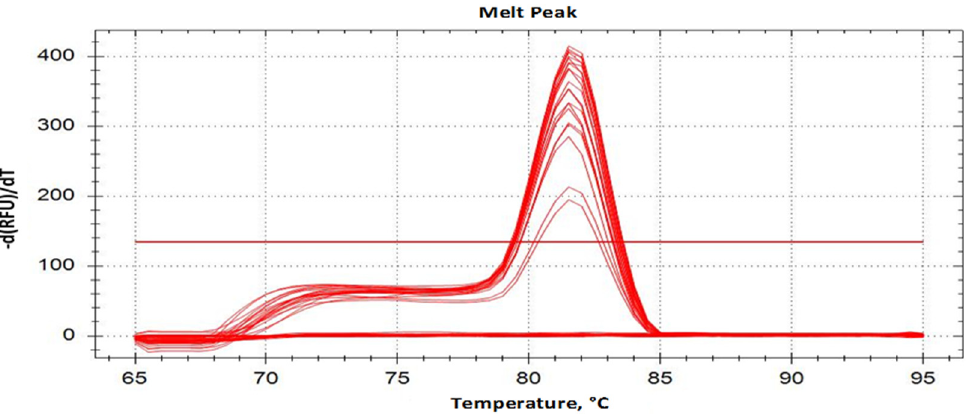
Figure 1. Melting curve profiles of P. dakotaensis . Amplicons with a single peak at a melting temperature of 81.5 °C were observed for populations of P. dakotaensis . Table 2. Taxon, geographic origin, current crop, and polymerase chain reaction (PCR) assays of the control nematode species used to test the specificity of IC-ITSF/ITS1R primer set designed to identify and detect P. dakotaensis.